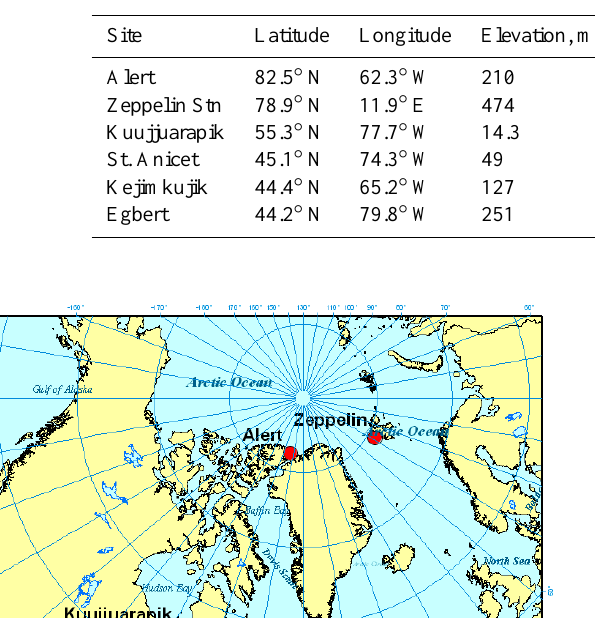
Table 1. Site details.